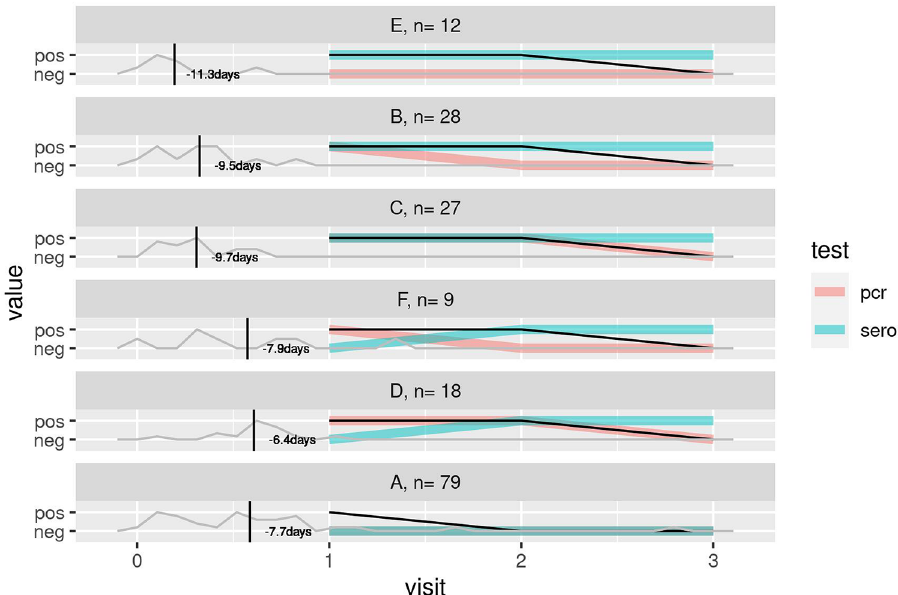
Figure 4. Common SARS-CoV-2 infection dynamics patterns, based on the presence or absence of a positive or negative RT-PCR or serological assay at visit 1, 2 and 3. Common patterns were named A–F based on frequency, with the number of individuals (n) displaying the pattern indicated. The median timing of onset of symptoms relative to visit 1 is indicated on the left. The black line indicates whether on average symptoms were reported at visit 1, 2 or